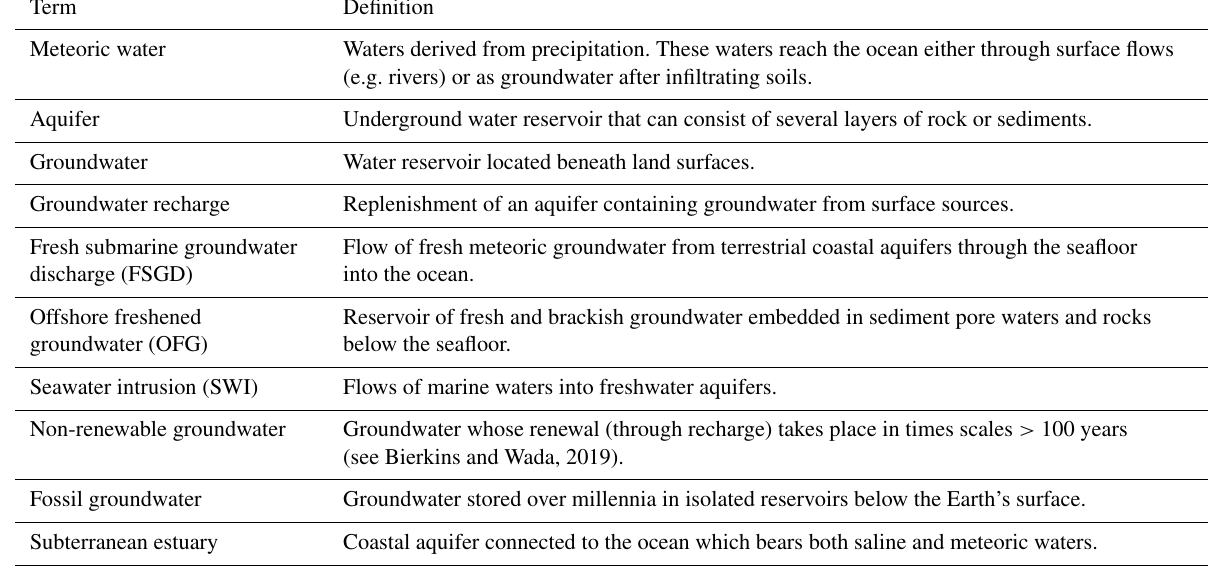
Table 1. Key concepts used in this manuscript.